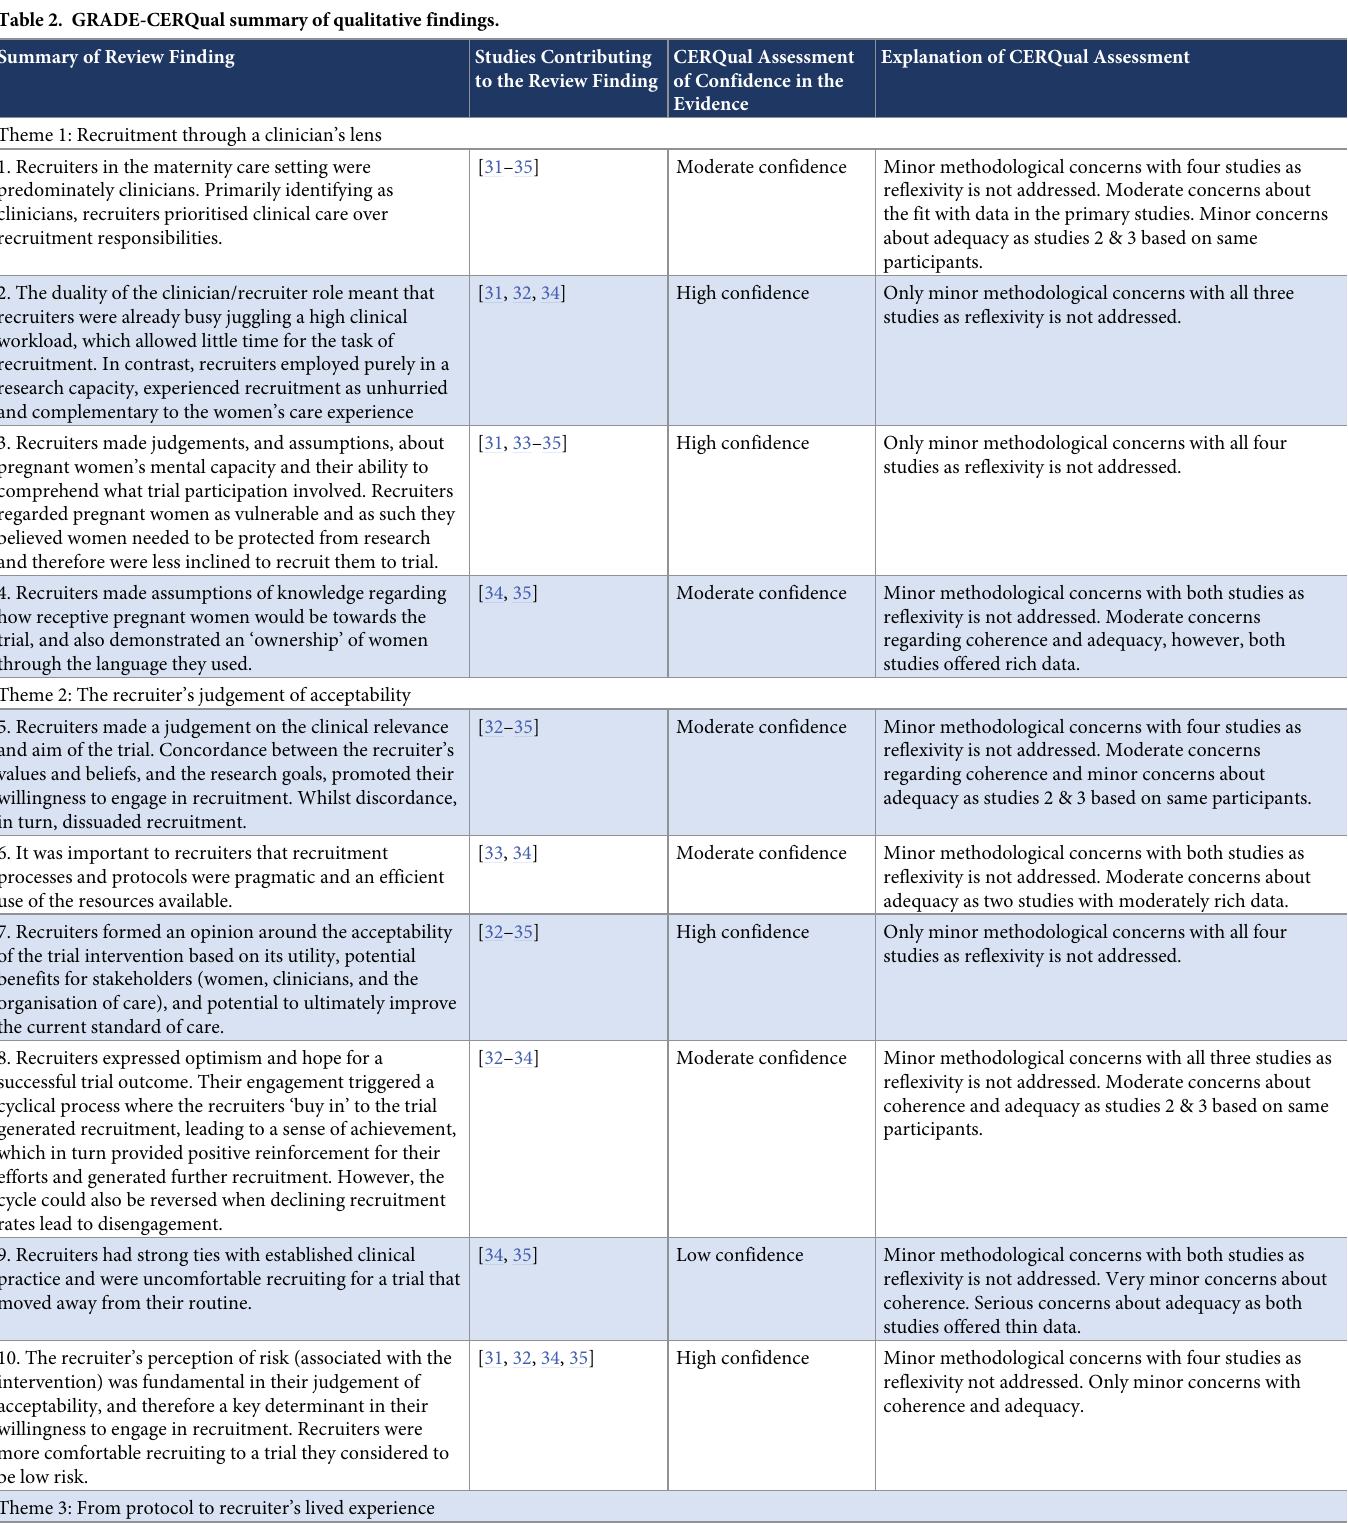
Table 2. GRADE-CERQual summary of qualitative